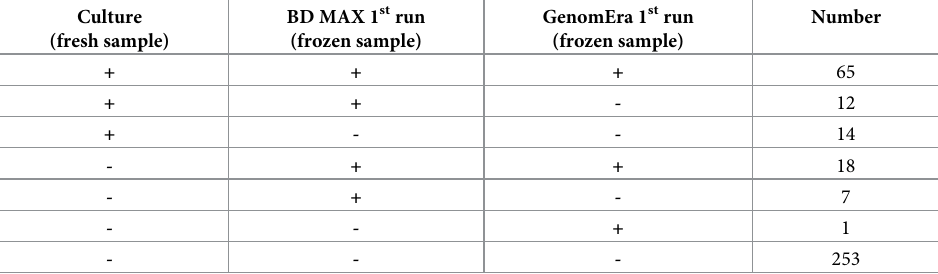
Table 1. First run PCR results with culture as